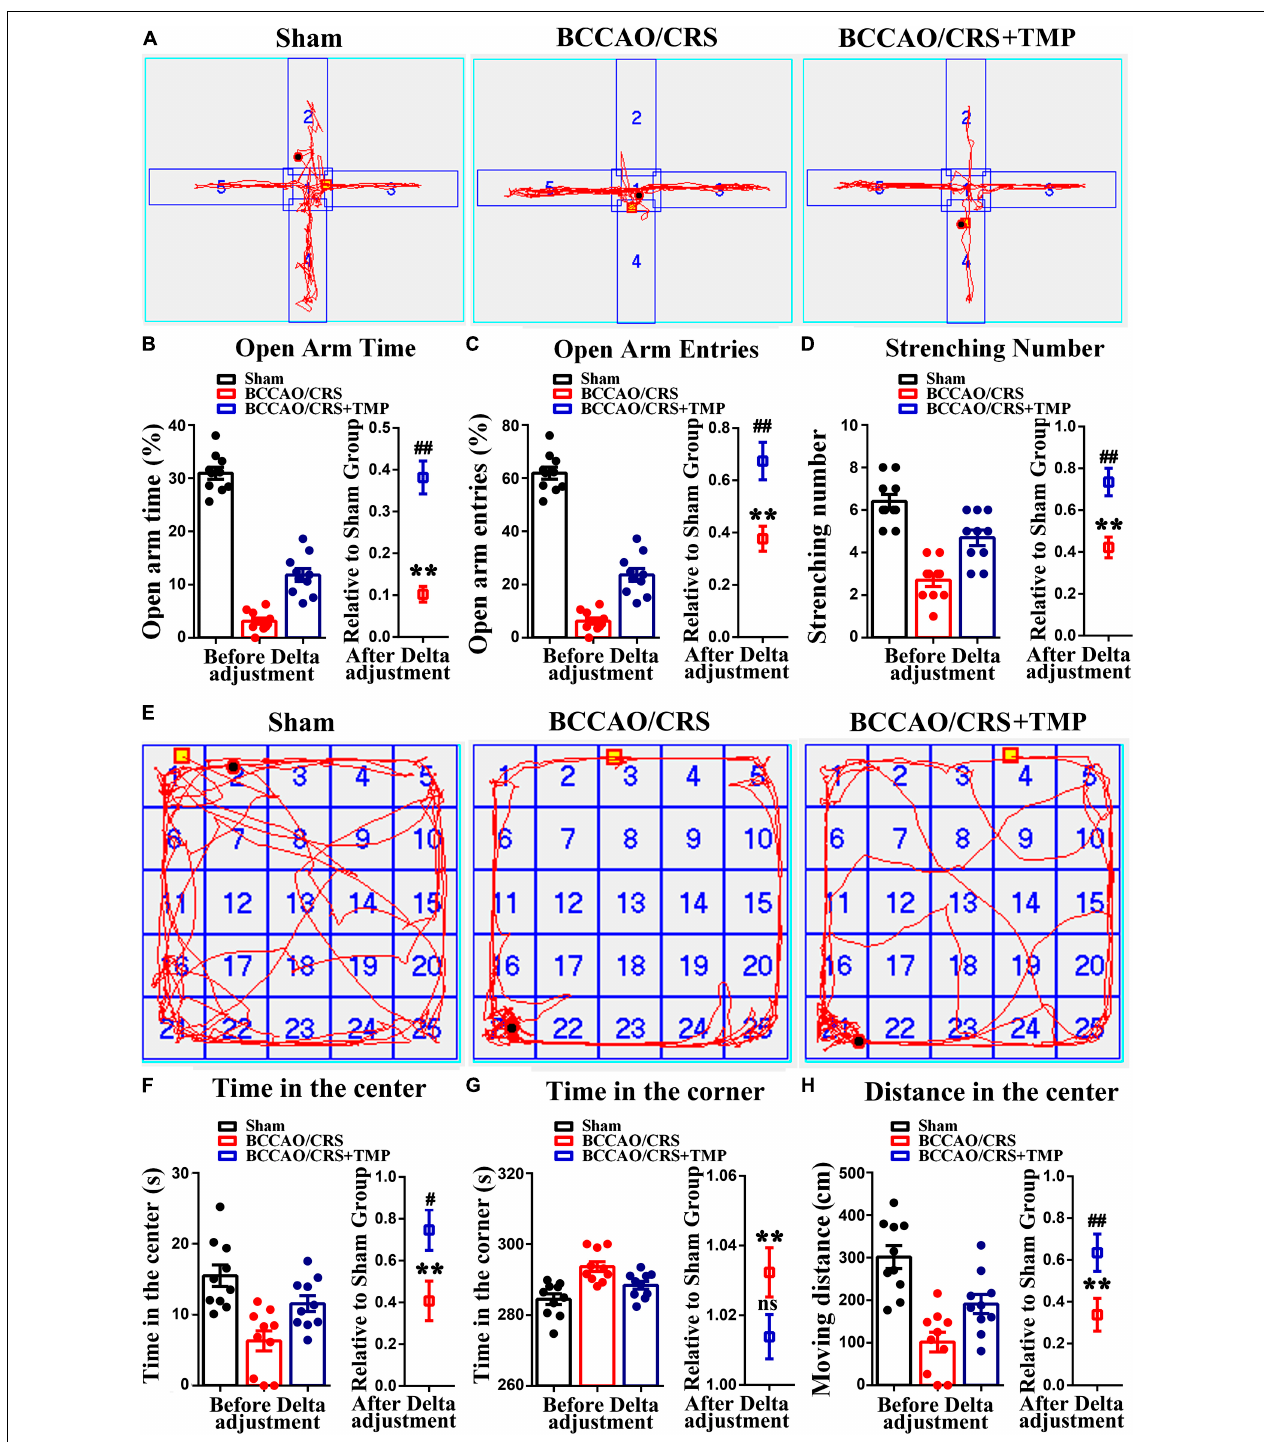
FIGURE 3 | Tetramethylpyrazine (TMP) administration alleviates depression and anxiety in rats caused by BCCAO/CRS. (A) Representational traces showing rats moving in the elevated plus maze (EPM) test. (B) Bargraph indicating the percentage of time that rats were moving/staying in the open arms. (C) Barchart demonstrating times that rats entered the open arms during EPM test. (D) Quantitation of the stretching number in rats during EPM test. (E) Typical route representing rats moving in the open field. (F) Summarized data demonstrating the total time of rats in the center during OFT. (G) Quantitative data summarizing the total time of rats in the corner during OFT. (H) Quantitative analysis of rats moving distance during the OFT. ** P < 0.01 vs. Sham. # P < 0.05, ## P < 0.01, ns P > 0.05 vs. BCCAO/CRS. Data are presented as mean ± SE. n = 10 in each group.